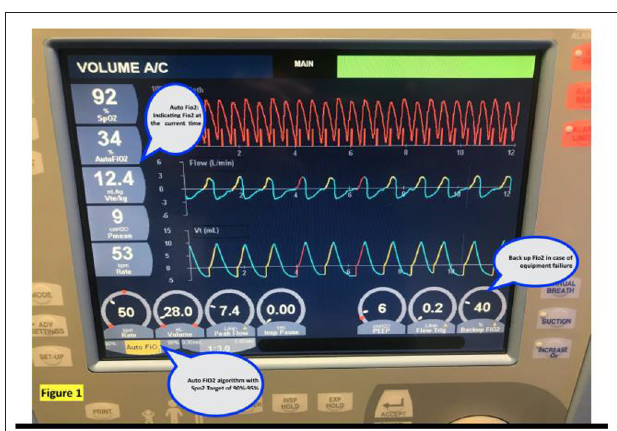
FIGURE 1 | CLiO TM 2 integral to the Avea r infant